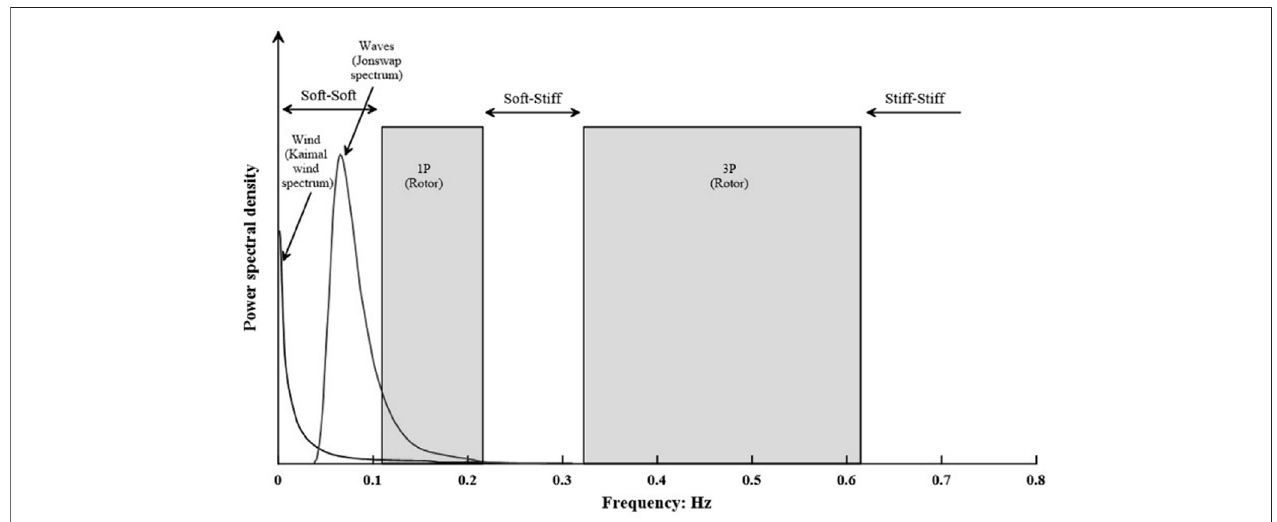
FIGURE 12 | Typical 1P and 3P bands of an offshore wind turbine (Jonkman et al.